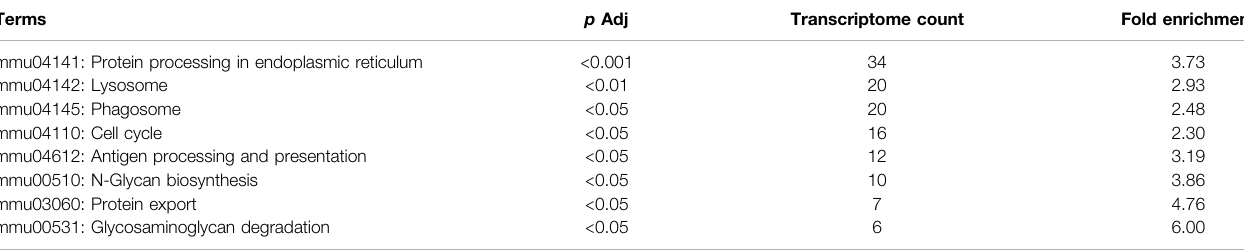
TABLE 2 | Signi fi cant KEGG pathways from differentially expressed genes. Terms p Adj mmu04141: Protein processing in endoplasmic reticulum